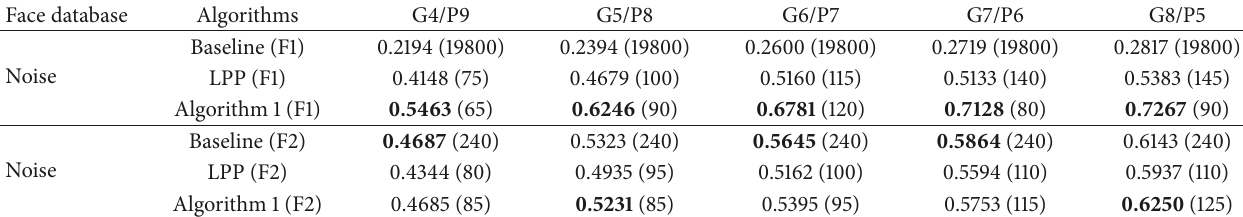
Table 4: The recognition rates on noise AR face database over “F1” and “F2” features; recognition rates (dimensionality).